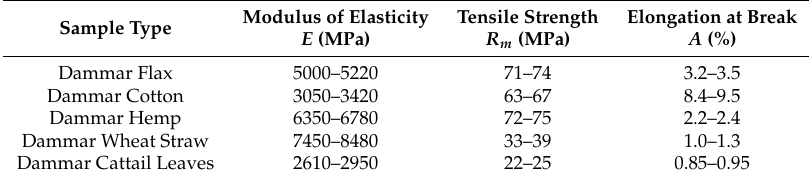
Table 6. The value limits of the modulus of elasticity, tensile strength, and elongation at break for the composite material samples studied.